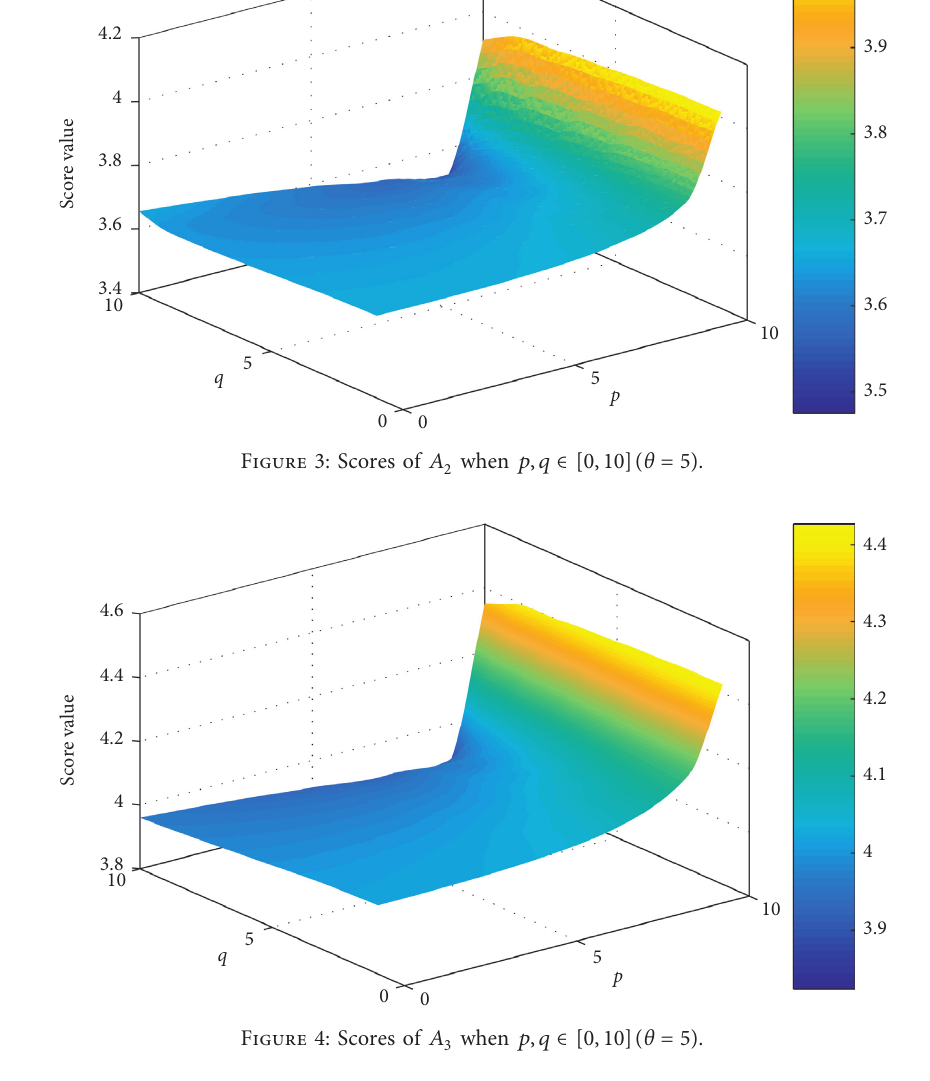
when p,q ∈ [ 0 , 10 ]( θ � 5 ) . 3